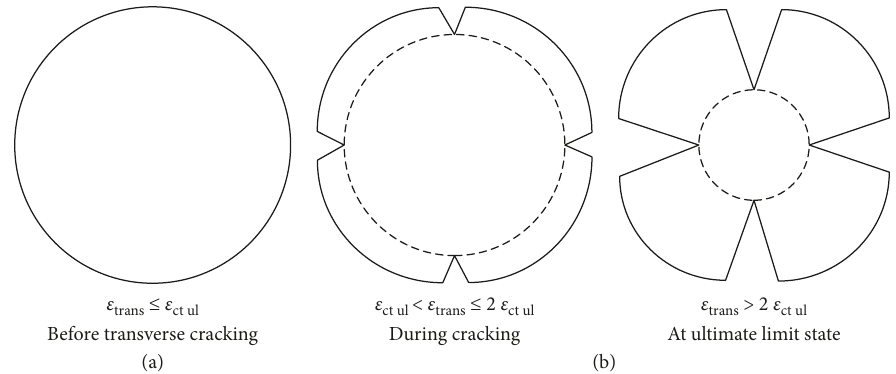
Figure 4: Development of transverse deformations and cracks at stages 1 (a) and 2 (b) for cylindrical HSC